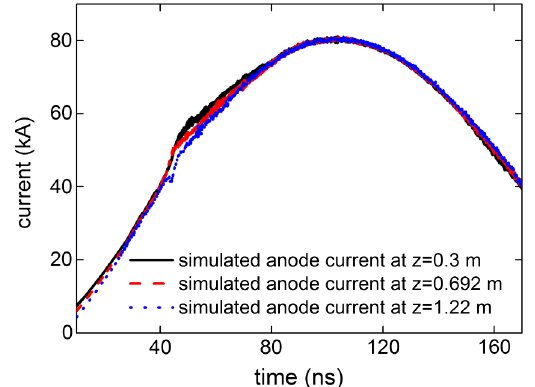
FIG. 13. Simulated electron currents at z ¼ 0 : 3 m and z ¼ 0 : 692 m . It can be inferred that electron emission turns on earlier at downstream, but the employment of support does not result in extra